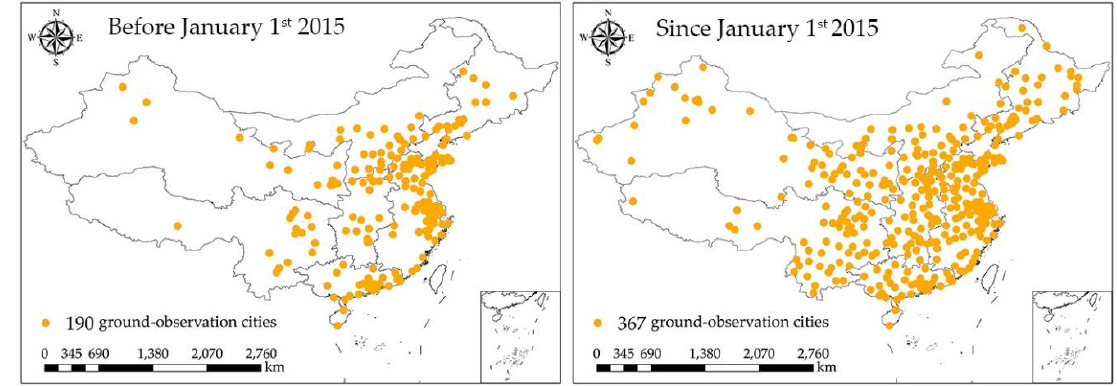
Figure 2. The location of ground-monitoring air quality stations.